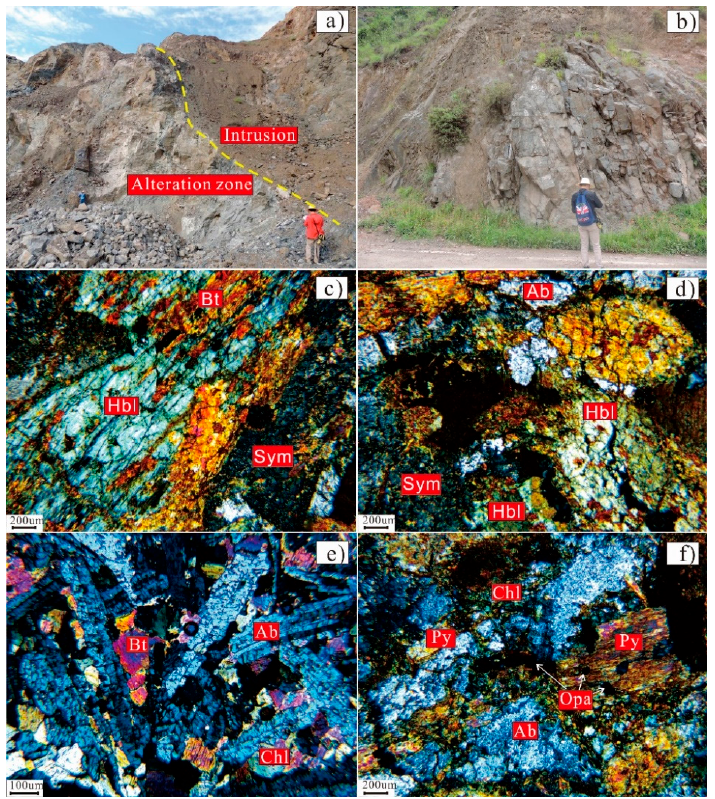
Figure 3. Outcrop photographs and photomicrographs of the basic rocks of the LTQ. ( a ) Field photos show the intrusion intrudes the dolomite of the Heishan Fm; ( b ) Field photos of the LTQ; ( c , d ) Microphotographs of the rock-forming minerals; ( e , f ) Microphotographs of minerals with hydrothermal alteration. Ab = Albite, Bt = Biolite, Chl = Chlorite, Hbl = Hornblende, Opa = Magnetite/Ilmenite, Py = Pyroxene, Sym = Symplectite.